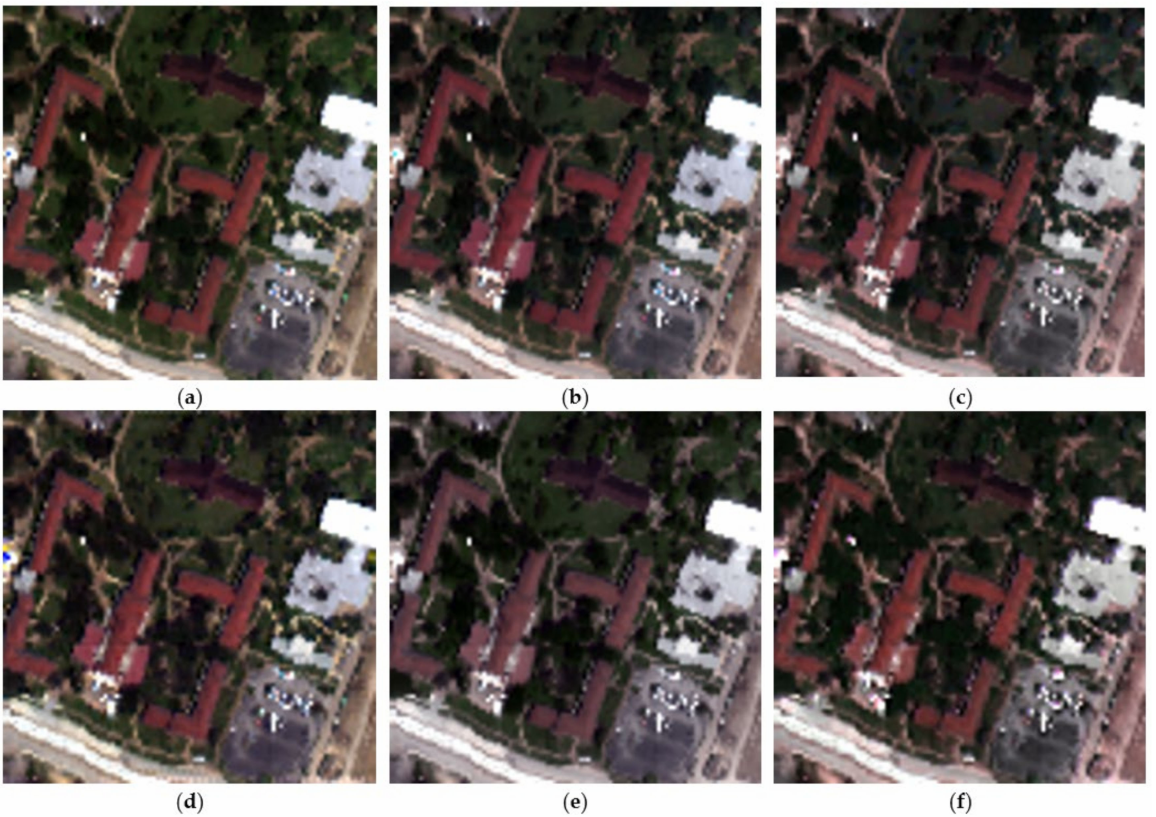
Figure 5. True-color image composite for the synthetic dataset. ( a ) Original hyperspectral image; ( b ) Obtained HSB-SV sharpened hyperspectral image; ( c ) Obtained HMF-IPNMF sharpened hyper- spectral image; ( d ) Obtained HySure sharpened hyperspectral image; ( e ) Obtained CNMF sharpened hyperspectral image; ( f ) Obtained FuVar sharpened hyperspectral